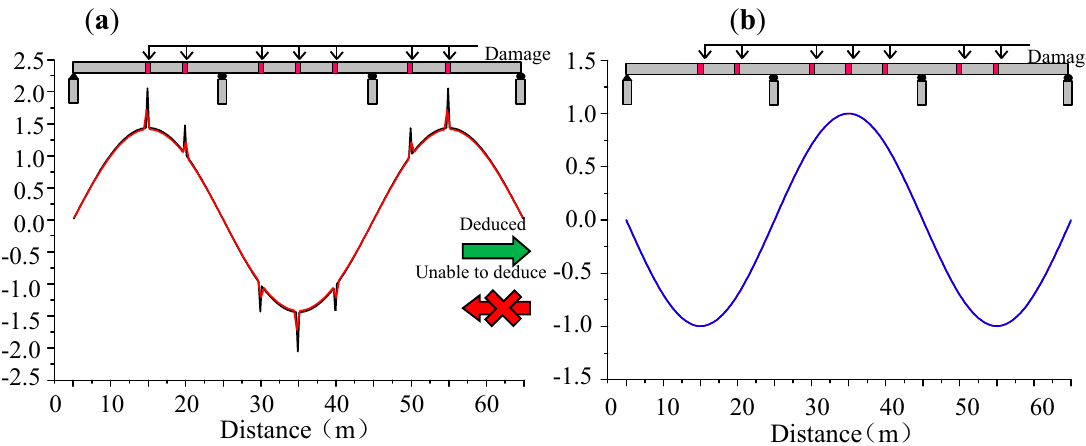
Figure 7. Advantage of the long gauge strain modal theory [63]. ( a ) Strain Mode Shape. ( b ) Displacement Mode Shape.